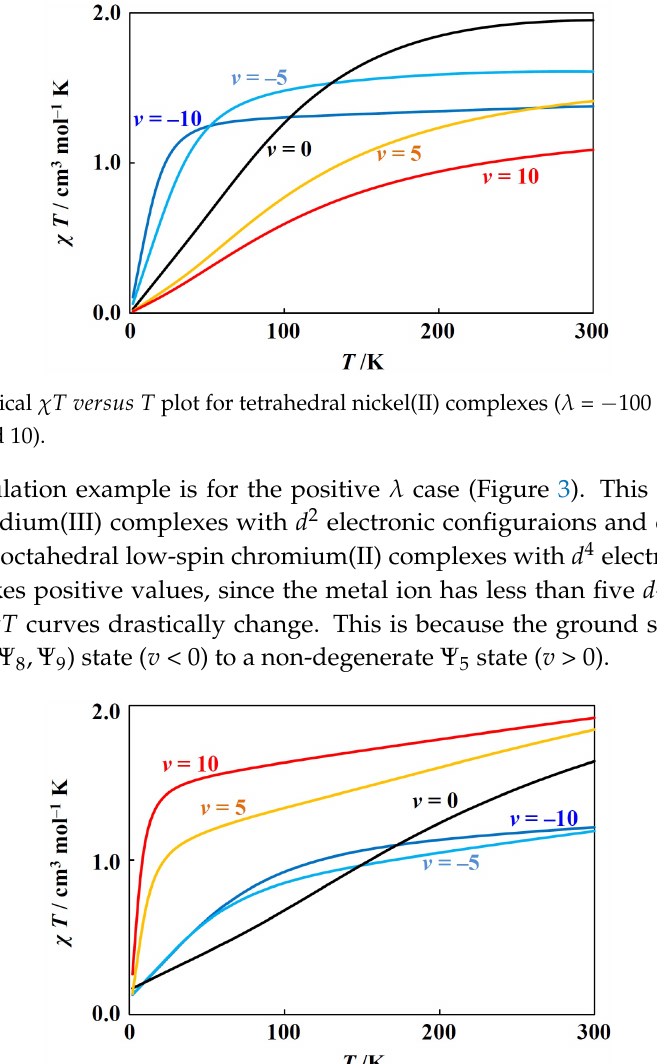
Figure 3. Theoretical χ T versus T plot for octahedral low-spin manganese(III) complexes ( λ = 100 cm − 1 , κ = 0.9, v = − 10, − 5, 0, 5, and